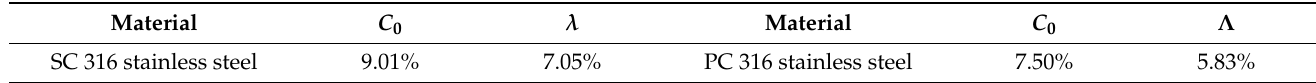
Table 2. Relative errors of Hugoniot parameters of 316 stainless steel.